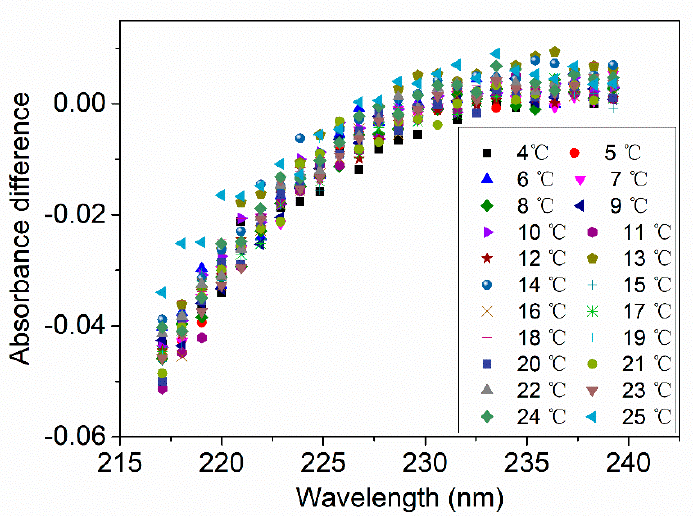
Figure 12. Absorbance difference ( A LNS − A OS ) between the LNS in this paper and the oligotrophic seawater in reference [37]. A LNS can be calculated by Equation (4) and A OS can be calculated by Equation (17).